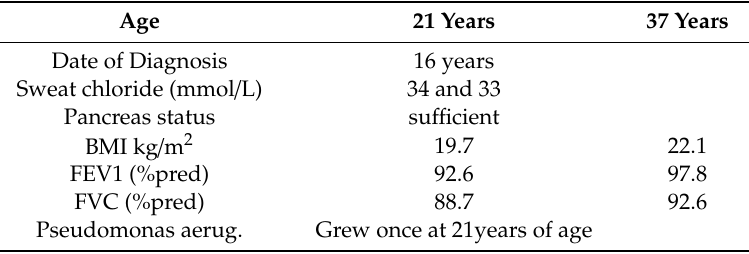
Table 2. Clinical data of the patient homozygous for D1152H /